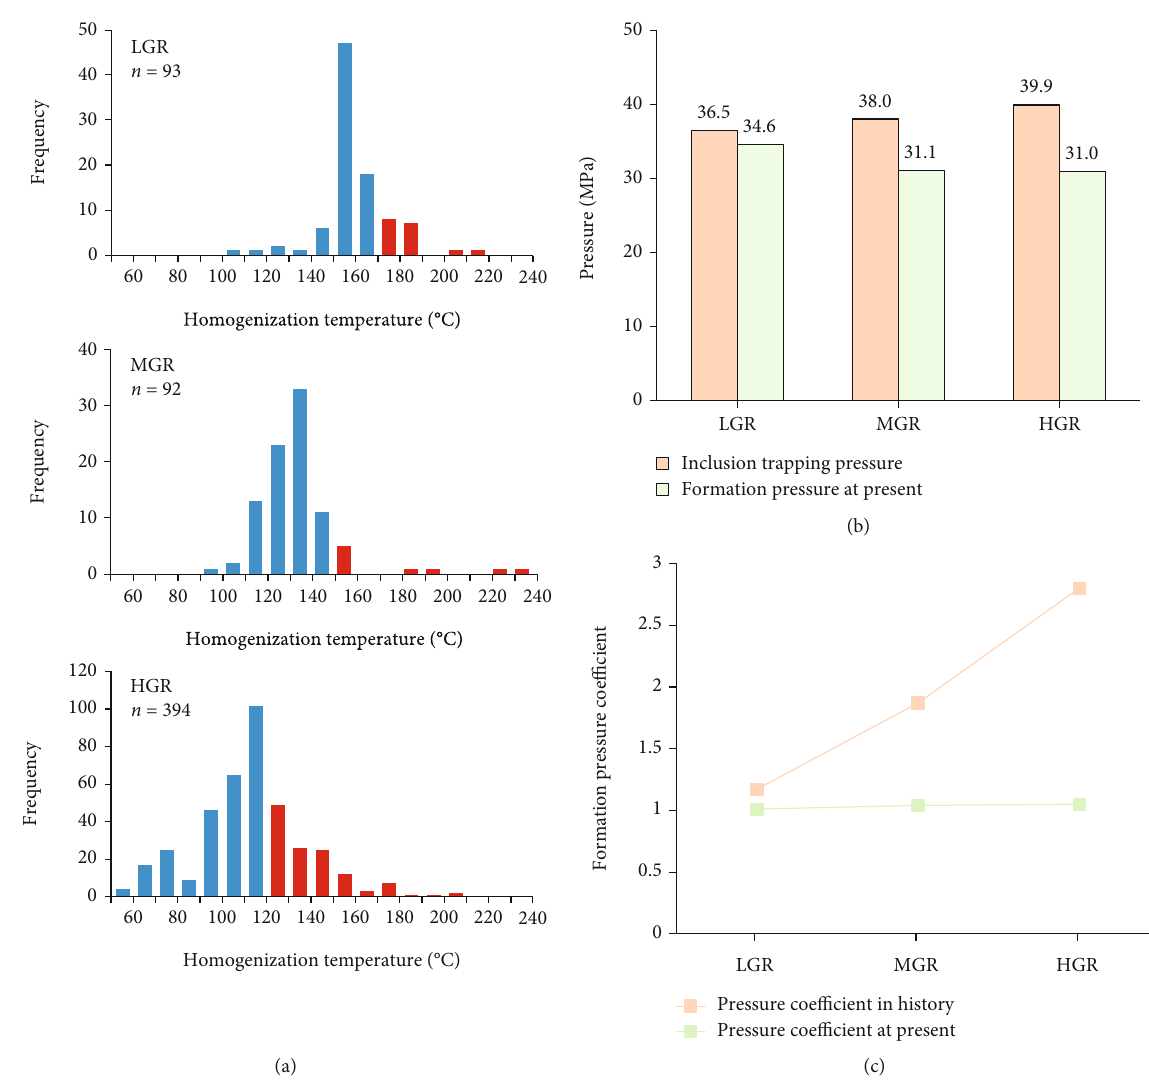
Figure 5: (a) Homogenization temperature frequency of inclusions, the red color represents the inclusions which homogenization temperature beyond the highest temperature of the Zhuhai Formation, and the blue color represents the inclusions which homogenization temperature below the highest temperature of the Zhuhai Formation. (b) Comparison of inclusion trapping pressure and formation pressure at present. (c) Comparison of paleopressure coe ffi cient and formation pressure coe ffi cient at